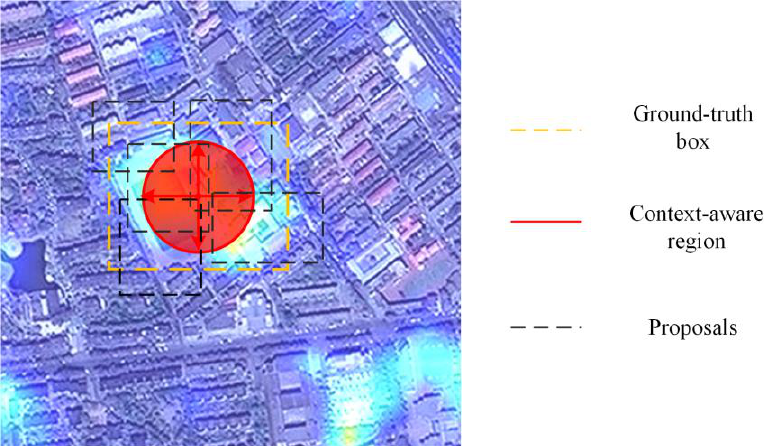
Figure 4. Context-aware strategy. Yellow box: ground-truth. Red circle: context-aware region. Black boxes: possible proposals without context-aware strategy.